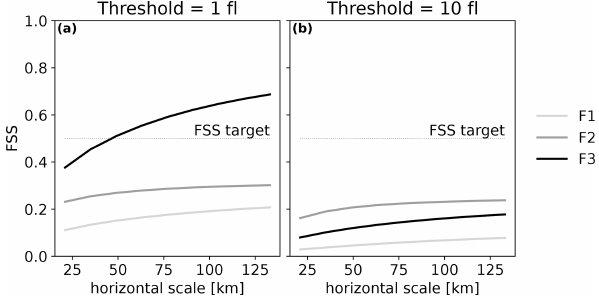
Figure 17. FSS for the whole validation period for FEA modelled with F1, F2 and F3 for two different thresholds.